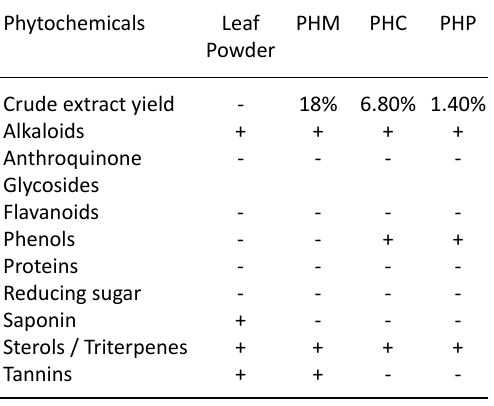
Table 2. Results of antibacterial activity of Parthenium hysterophorus extracts Pathogen